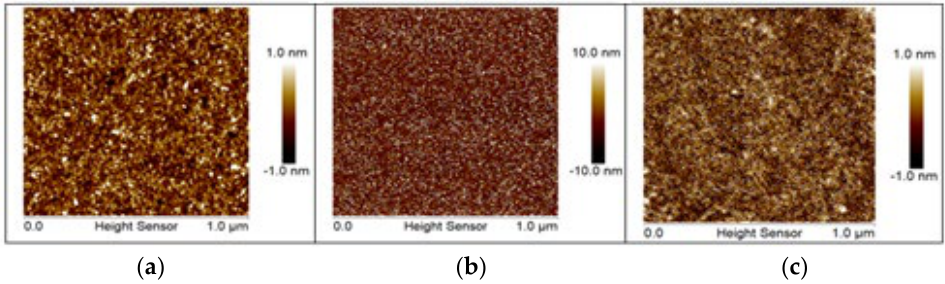
Figure 2. Characterization of the sample surface roughness with atomic force microscopy (AFM) in tapping mode using post-deposition annealing process (PDA) at different temperatures of 400 °C ( a ), 500 °C ( b ), and 600 °C ( c ).